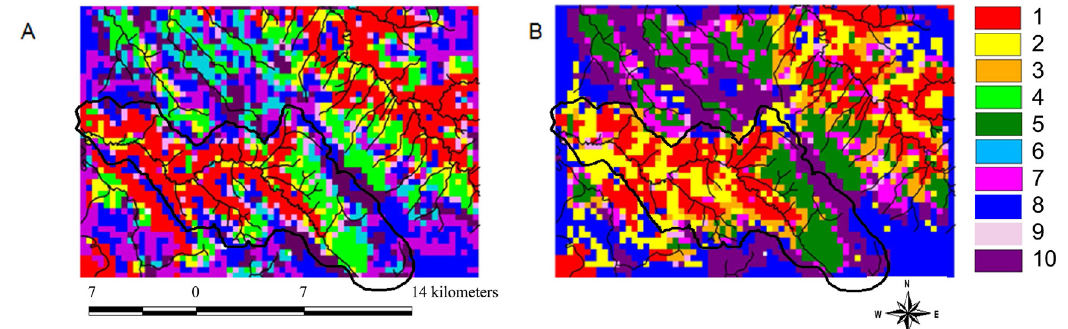
Figure 4: Maps of partial geosystems based on the deterministic model: “Properties of geosystems (D ) are strictly rg determined by landforms combination in the square neighborhood”. Colors correspond to the types of units embedded into the higher-order geosystems with linear dimensions: A – 1200 m (properties of herb, low shrub, shrub layers, soil horizons), B – 2000 m (properties of tree and shrub layers). Bold black curve – boundary of the Zayachya river basin Relief properties: 1 – rugged terrains with dense erosion network; 2 – flat terraces and marginal parts of narrow flat interfluves; 3 (B) – slightly concave catchment areas with flat slopes; 4 (A) and 5 (B) green – gentle slightly dissected slopes; 6 (A) – Slightly convex narrow interfluves with gentle slopes; 7 (B) – flat interfluves surrounded by the upper reaches of the valleys; 8 – wide flat poorly drained interfluves; 9 (A) - flat drained interfluves; 10 – narrow flat poorly drained